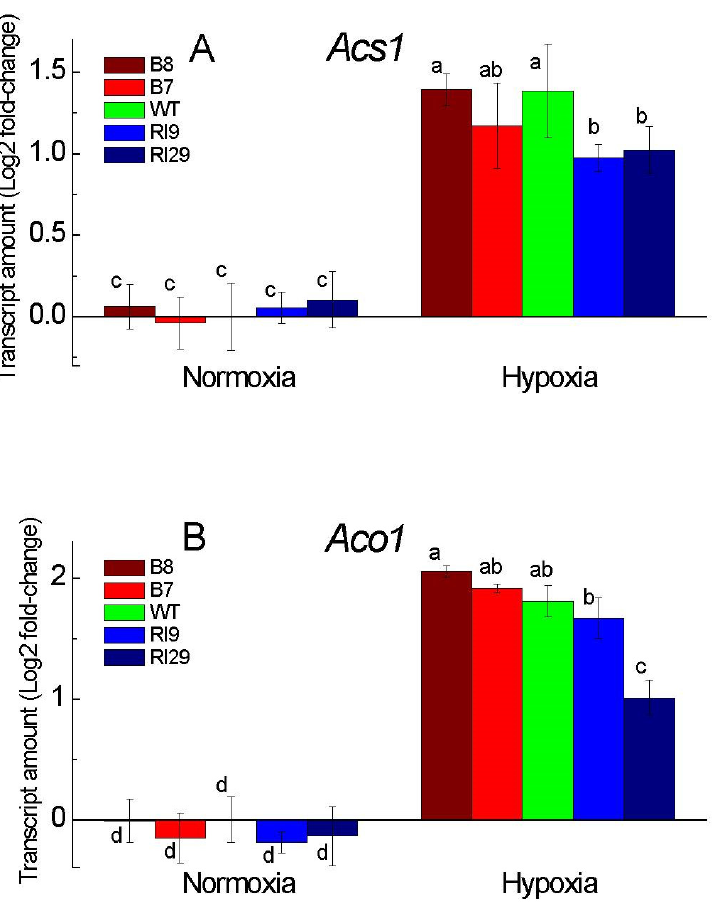
Figure 6. Transcript levels of the genes encoding 1-aminocyclopropane-1-carboxylic acid synthase ( Acs1 ) ( A ) and 1-aminocyclopropane-1-carboxylic acid oxidase ( Aco1 ) ( B ) in leaves of tobacco plants exposed to normoxia and 6 h hypoxia. The plant lines used included the wild type (WT), two alternative oxidase overexpressors (B7 and B8), and two alternative oxidase knockdowns (RI9 and RI29). Vertical bars indicate SD from three to four independent experiments ( n = 3–4); different letters indicate significant differences between five tobacco lines and the treatments. The expression of four factors of the ethylene response factor family (ERF1, ERF3, survival in low-oxygen environments (Figure 7), also showed the response to hypoxia, which in some cases was affected by AOX expression. In air, all plant lines exhibited almost the same low expression level of all ERFs tested in this study. The hypoxic treatment increased ERFs transcripts abundance in all plant lines, compared to normoxia. After 6 h of hypoxia, ERF1 and ERF4 transcript amounts were significantly higher in the overexpression plants and WT, as compared to the knockdowns, showing the lower transcript amount (Figure 7A,C). All plant lines showed similar high mRNA levels of ERF3 and ERF5 under hypoxia treatment (Figure